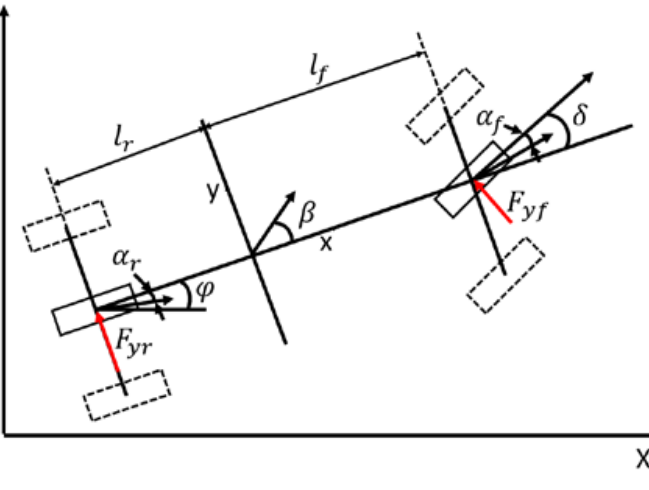
Figure 1. Bicycle model of a vehicle.